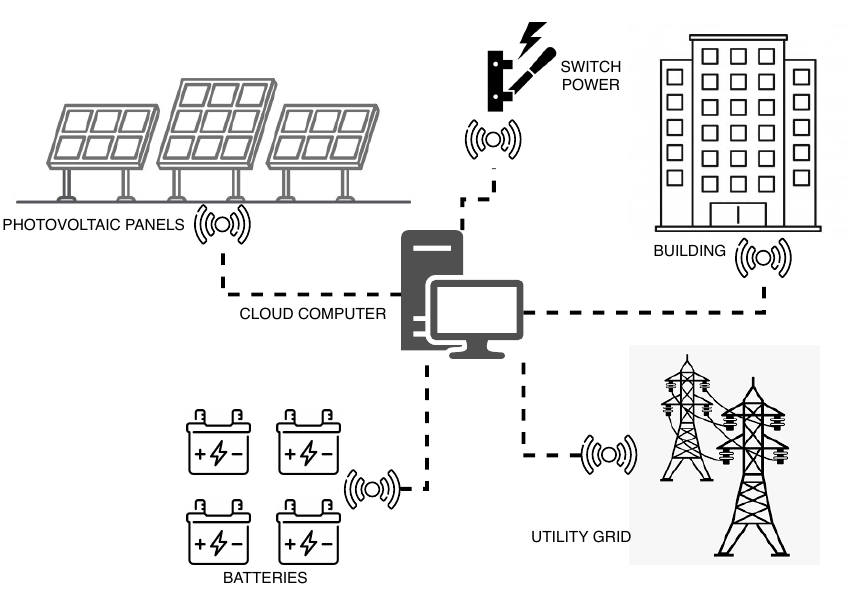
Figure 4. Proposed Internet of Things (IoT) environment.